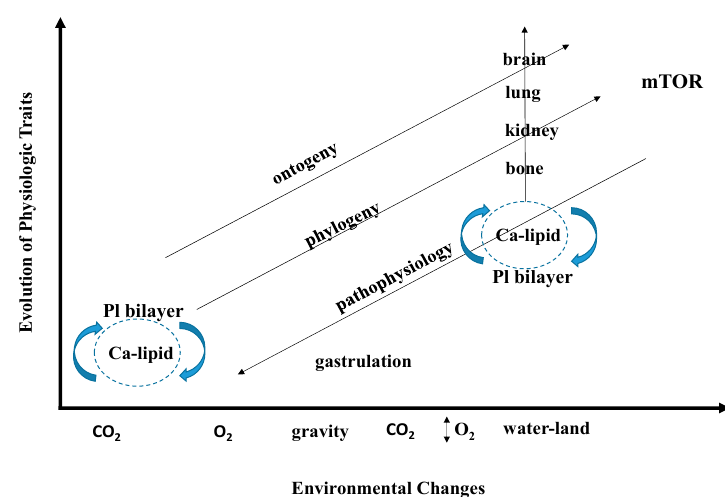
Figure 2. Physiologic evolution as one continuous Arc. from the inception of micelles from phospholipid bilayers (lower left corner, “Pl bilayer”) ontogeny, phylogeny and pathophysiology have formed parallel lines for the generation (or degeneration) of physiologic traits (Y-axis). Under selection pressure due to environmental changes (X-axis), exaptations have occurred, referring back to the unicellular First Principles of Physiology. This process of evolution gave rise to complex traits (bone, kidney, lung, brain), all of which funnel through the mammalian Target of Rapamycin (mTOR) gene, shown in the upper right.